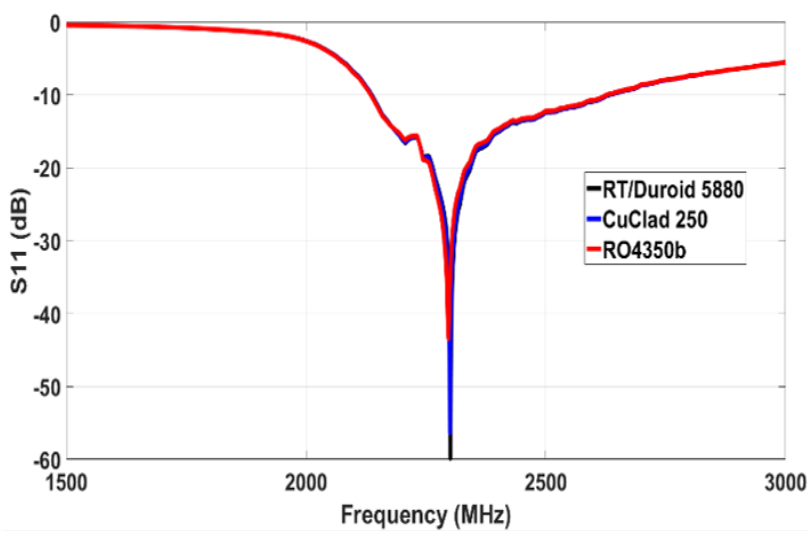
Figure 6. Input reflection parameter (S 11 ) simulation for the selected RF substrates centered at 2.25 GHz.